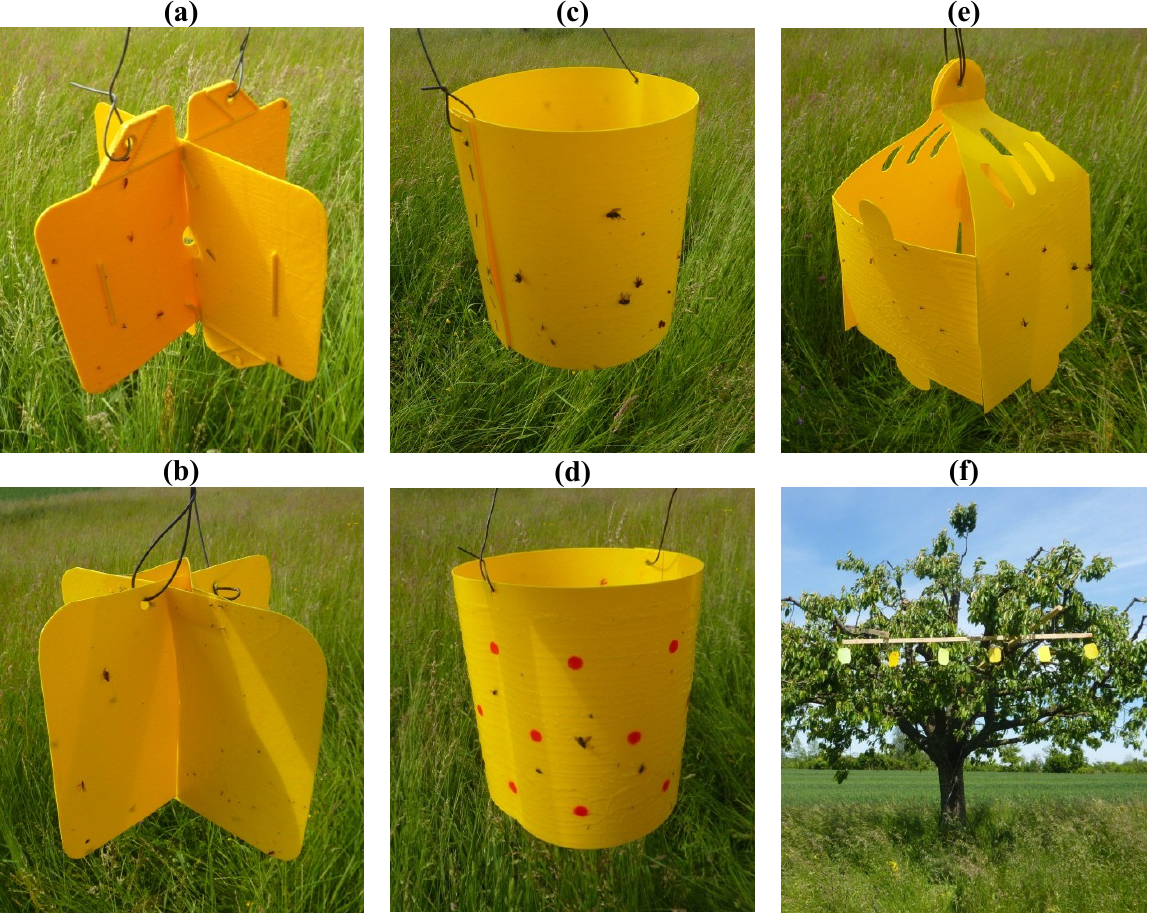
Figure 2. Trap shapes tested in the experiment: ( a ) Rebell ® amarillo (cross); ( b ) cross- shaped trap; ( c ) cylinder-shaped trap; ( d ) dotted cylinder-shaped trap; ( e ) cube-shaped trap (the ―roof‖ was not glued); ( f ) one replicate of Experiment 1: a comparison of differently-colored